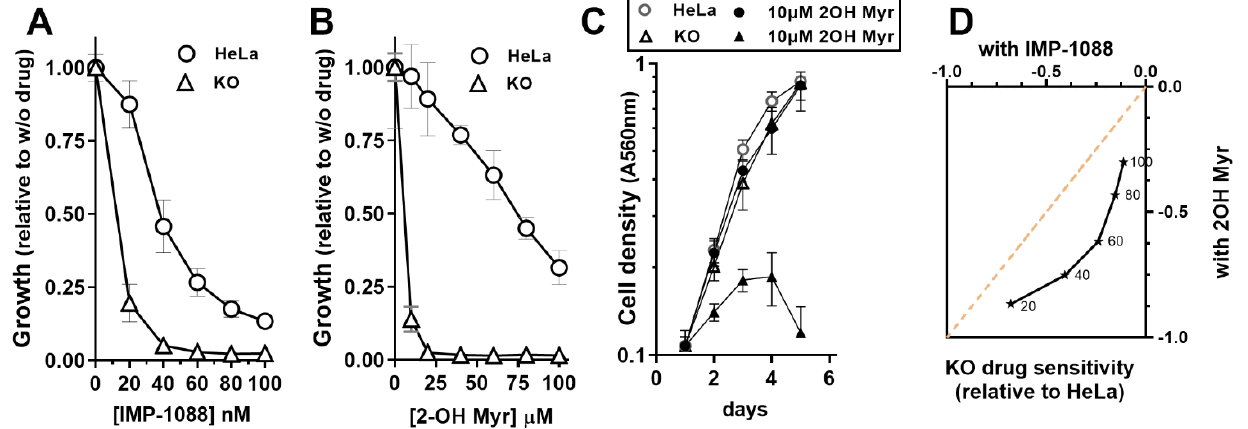
Figure 4. Impaired NMT activity in ACBD6.KO cells challenged with NMT inhibitors. HeLa and ACBD6.KO cells were grown in 96-well plates and exposed to the indicated concentration of IMP-1088 ( A ) and 2-hydroxymyristate (2-OH Myr) ( B ). Growth of cells in the absence or the presence of 10 µM 2-OH Myr are presented in ( C ) . Cells were fixed in 10% ice-cold TCA, stained with the SRB dye, and absorbance was read at 560 nm [3]. In ( A , B ), the values obtained in the presence of the drugs are reported relative to the values obtained in their absence ( p < 0.0001). Error bars represent the standard deviations of values obtained from 12 measurements. ( D ) The values of the growth inhibition difference of the ACBD6.KO cells relative to HeLa obtained in the presence of IMP-1088 at the indicated concentrations ( A ) were plotted as a function of the values obtained in the presence of 2-OH Myr ( B ). The dashed line represents the plot of the theoretical values in a scenario of identical sensitivity for the two inhibitors.